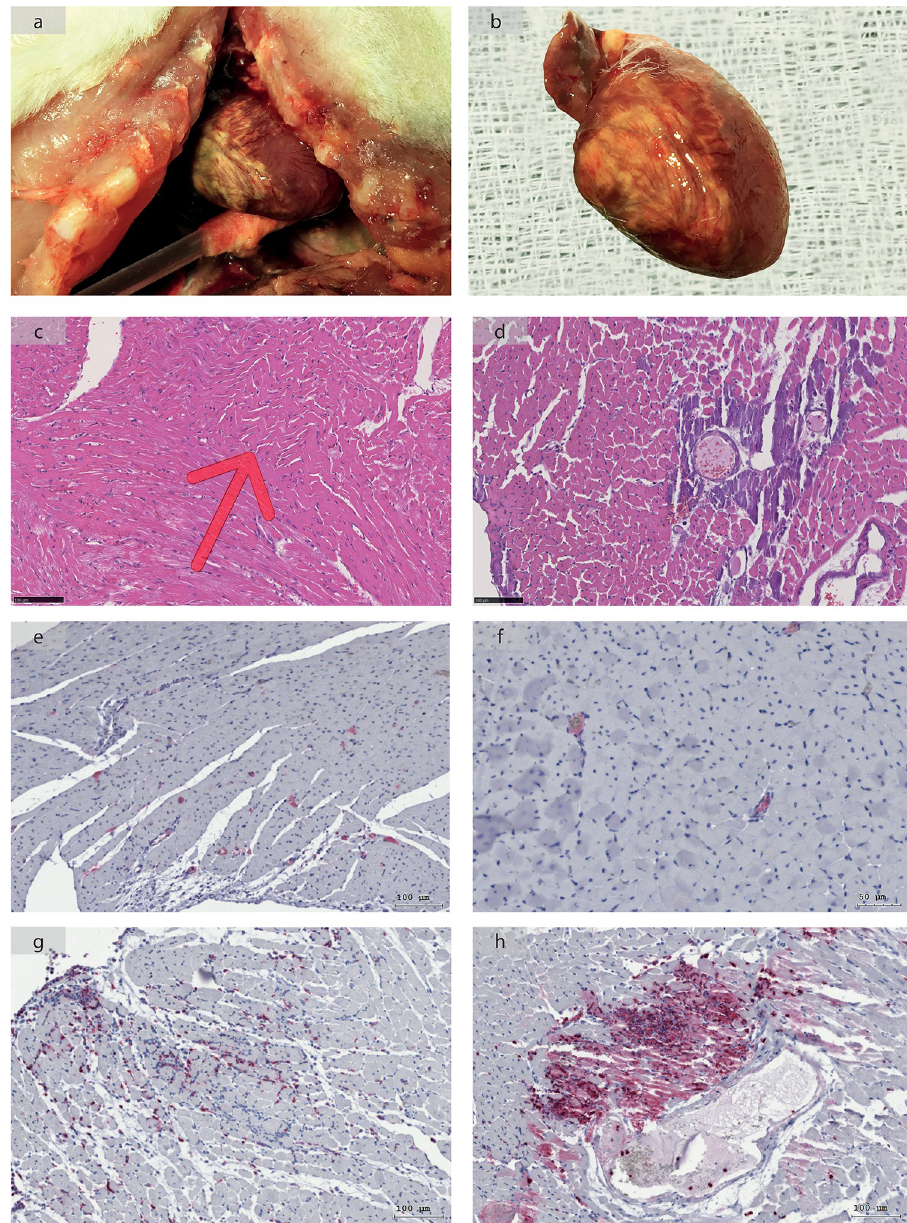
Fig 3. Macroscopic and histologic examination of heart and heart tissue of animals that died early after Bile Duct Ligation (BDL) showed signs of myocardial injury. (a, b) The hearts of early deceased animals showed yellow demarcated areas. (c, d) Hematoxylin and eosin staining (HE) of these animals showed “wavy fibers” (red arrow) in addition to perivascular lesions. The myocardium appeared loosened in general. (e, f) CD41 staining showed microthrombi (red) in the capillary system in the myocardium of rats that died early after BDL. (g) Myeloperoxidase (MPO) staining showed diffuse spreading of neutrophil granulocytes (dark red) in myocardial tissue as well as (h) neutrophil granulocytes infiltrating perivascular lesions in rats that died early after BDL.